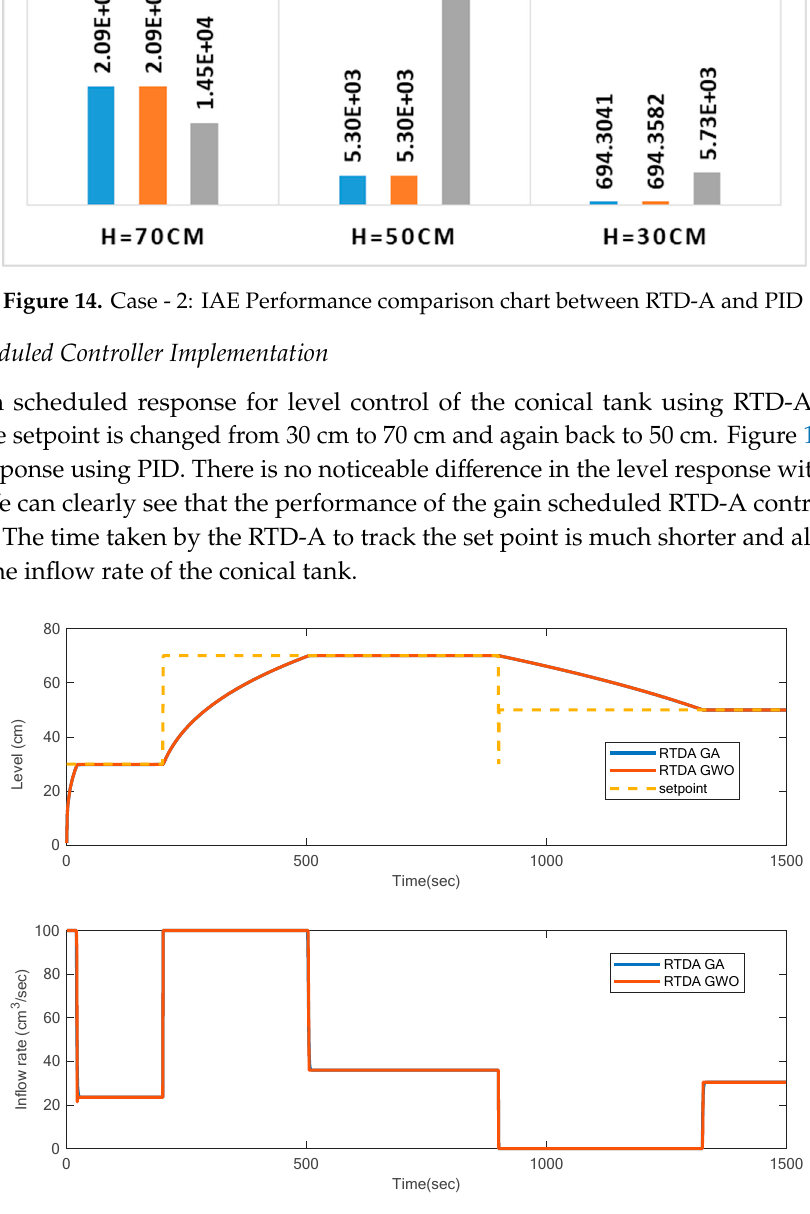
Figure 15. Gain scheduled level control of conical tank using RTD-A with GA and GWO.